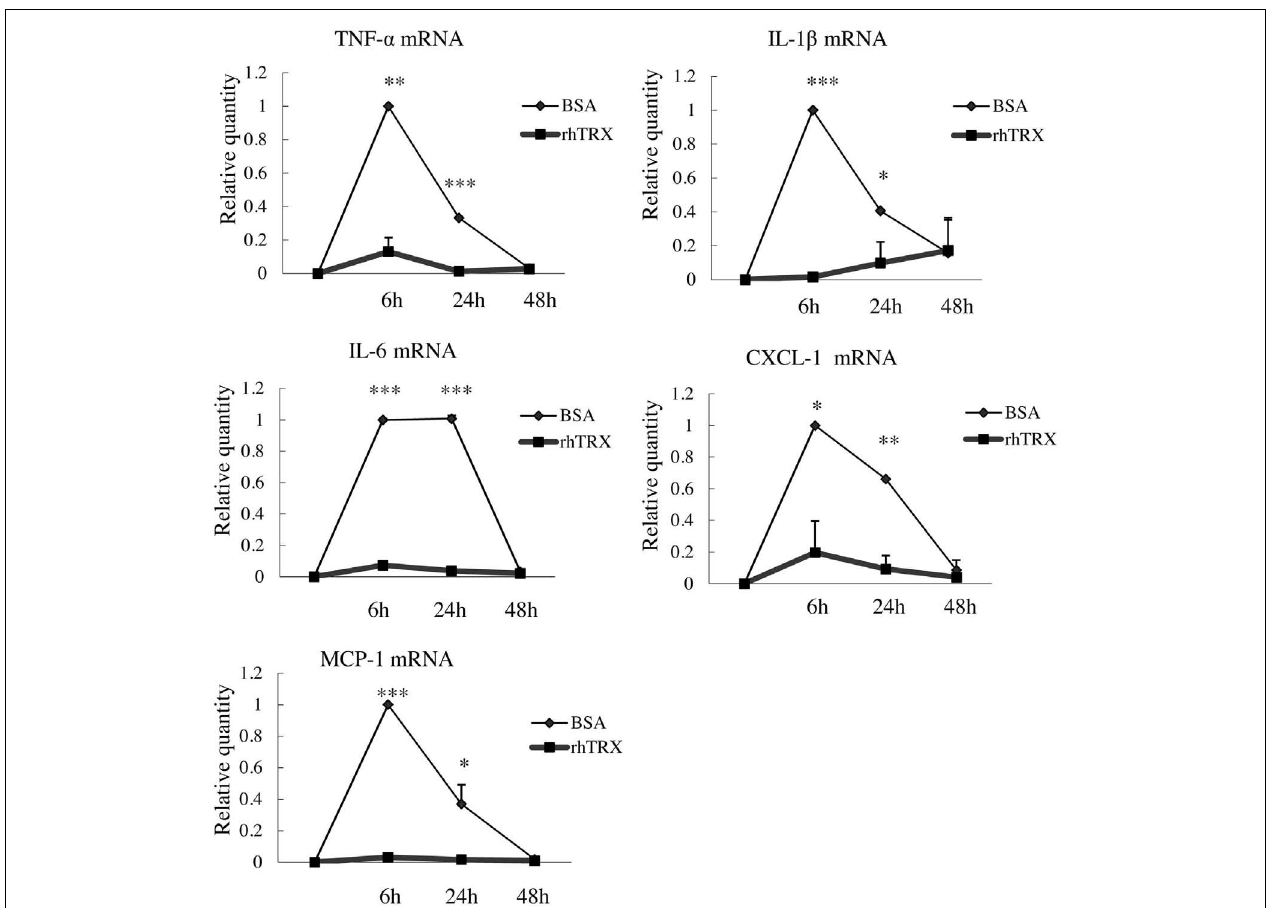
significantly suppressed the mRNA expression of the cytokines and the chemokines at 6 and 24h after the croton oil was applied.The mRNA expression levels were determined relative to croton oil-stimulated cells. Values are shown as the mean ± SD of three experiments (* P < 0.05, ** P < 0.01, *** P < 0.001) (Student t